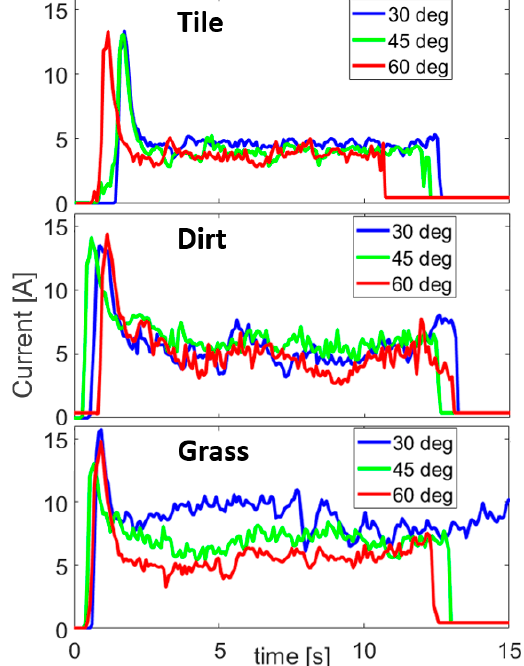
Figure 19. The current consumption of BSTAR over three different surfaces (tiles, dirt and grass) for three sprawl angles (30, 45 and 60 degrees) at its maximum output speed. Table 2. The power requirements of